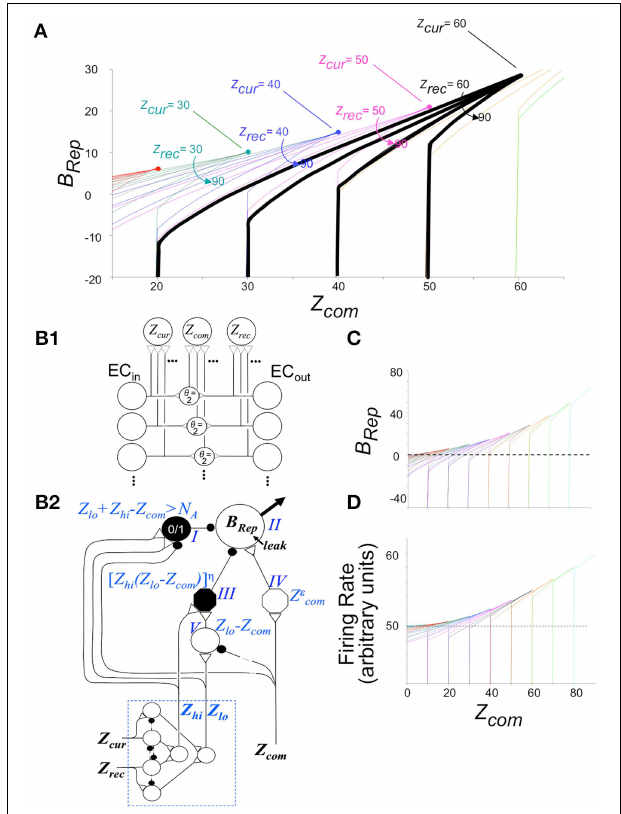
FIGURE 3 | Bayesian Weight of Evidence, B Rep : Exact calculations and neural circuit that emulates them. (A) Exact values of B Rep are plotted as a function of Z com for a variety of values of Z cur and Z rec . The values for a given value of Z cur are all in the same color. The values for Z rec = 60 and Z cur = 60–90 are made bold black to highlight one set of values for reference when reading the relevant text. (B) Neural circuit that approximates exact calculations. (B1) Circuit for getting rate-coded inputs Z cur , Z rec , and Z com to the rest of the circuit. It is assumed that Z cur , Z rec , and Z com fire at rates proportional to their number of active inputs; interneurons are binary cells that fire when both their inputs are active (i.e., threshold, θ = 2 ). (B2) B Rep computing circuit. Because B Rep is symmetrical with respect to Z cur and Z rec (i.e., their values can be exchanged without effect), these are transformed by the module at the lower left to Z lo and Z hi (the lower and higher of the two). Neurons of the computational module proper are labeled I–V for reference. Those represented as octagons do arithmetic that may itself require a small circuit (see Supplementary Material). Neuron II, which codes B Rep as a firing rate, is the output neuron of the circuit. It is given a leakage conductance that elevates its baseline potential and firing rate above zero so that that these can both increase, to convey confidence in the validity of the currently active representation, and decrease, to convey confidence that it is invalid. The remainder of the circuit was constructed to approximate the exactly calculated value of B Rep as a function of Z com , Z lo , and Z hi shown in (C) . When Z com , Z rec , and Z hi of the exact curves are equal, B Rep increases from zero as an accelerating function of the value of Z com , forming a curve that is the upper envelope of the set of full B Rep curves. This upper envelope is emulated by the output of neuron IV, which transforms Zcom into a power function of Z com with the exponent being chosen so that the firing rate of II will approximate the upper envelope of the exactly calculated curves. By definition, Z com cannot be greater than Z lo . For a given value of Z lo , B Rep is on the above-described envelope when Z com = Z lo = Z hi . It decreases as Z com decreases, at a rate that is greater, the greater Z hi , as seen in (C) . This behavior is emulated if neuron II is subject to divisive inhibition that is